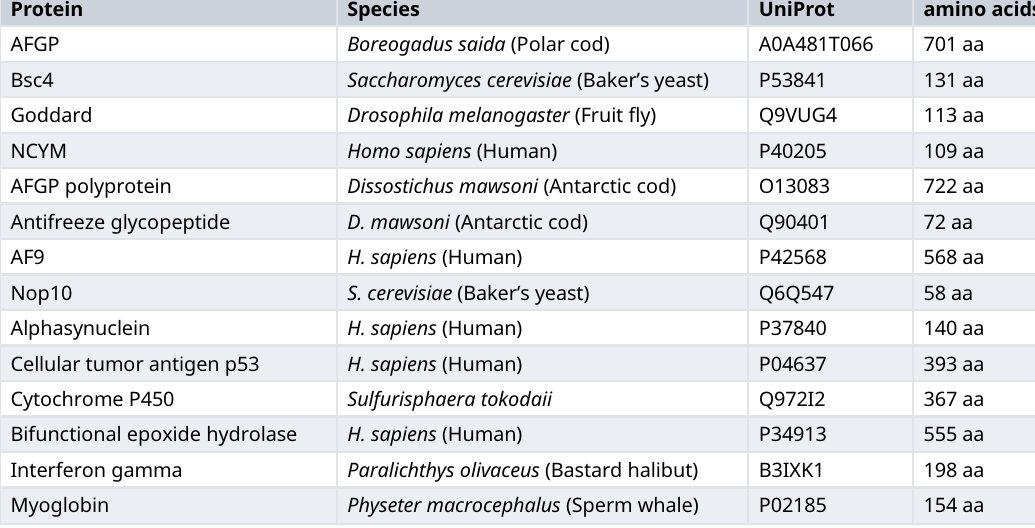
Table 1. Proteins